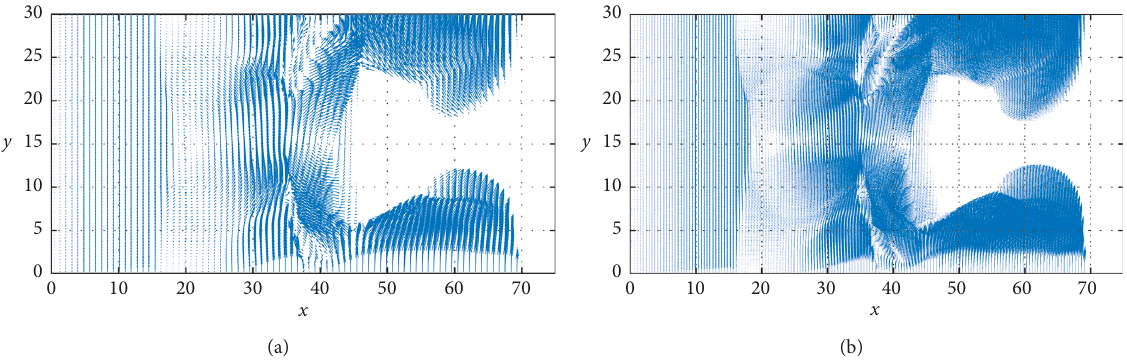
Figure 14: Velocity field using 85